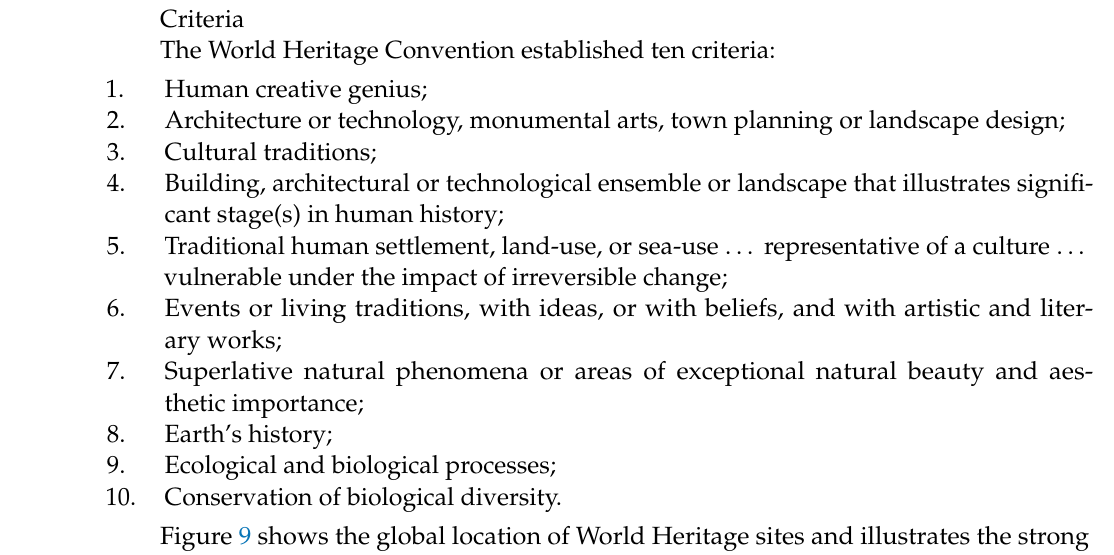
Figure 10. Cumulative listings of Criterion 7 sites ( http://whc.unesco.org/en/list ) (accessed on 19 January 2022).